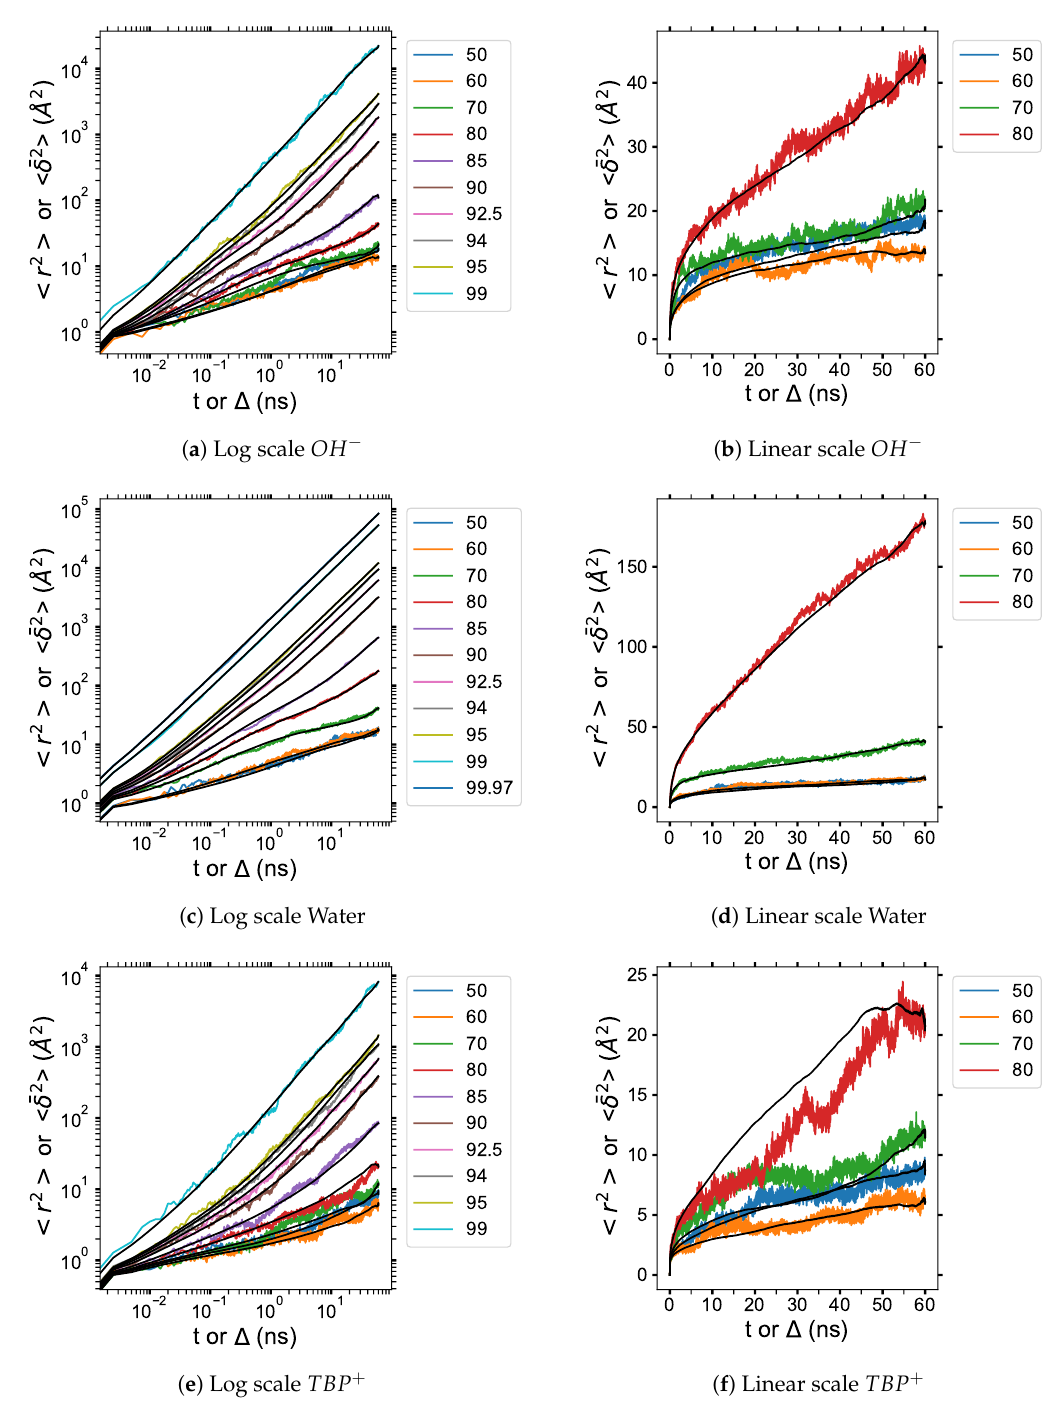
Figure A10. MSD vs. particle-averaged TAMSD of the water, TBP and OH in TBPH–water at p = 1atm and T = 300K as a function of water concentration: ( a ) MSD and particle-averaged TAMSD of OH − plotted on a log scale; ( b ) MSD and particle-averaged TAMSD of OH − plotted on a linear scale; ( c ) MSD and particle-averaged TAMSD of water plotted on a log scale; ( d ) MSD and particle-averaged TAMSD of water plotted on a linear scale; ( e ) MSD and particle-averaged TAMSD of TBP + plotted on a log scale; ( f ) MSD and particle-averaged TAMSD of TBP + plotted on a linear scale.The colored lines are the MSDs, and the black lines are the particle-averaged